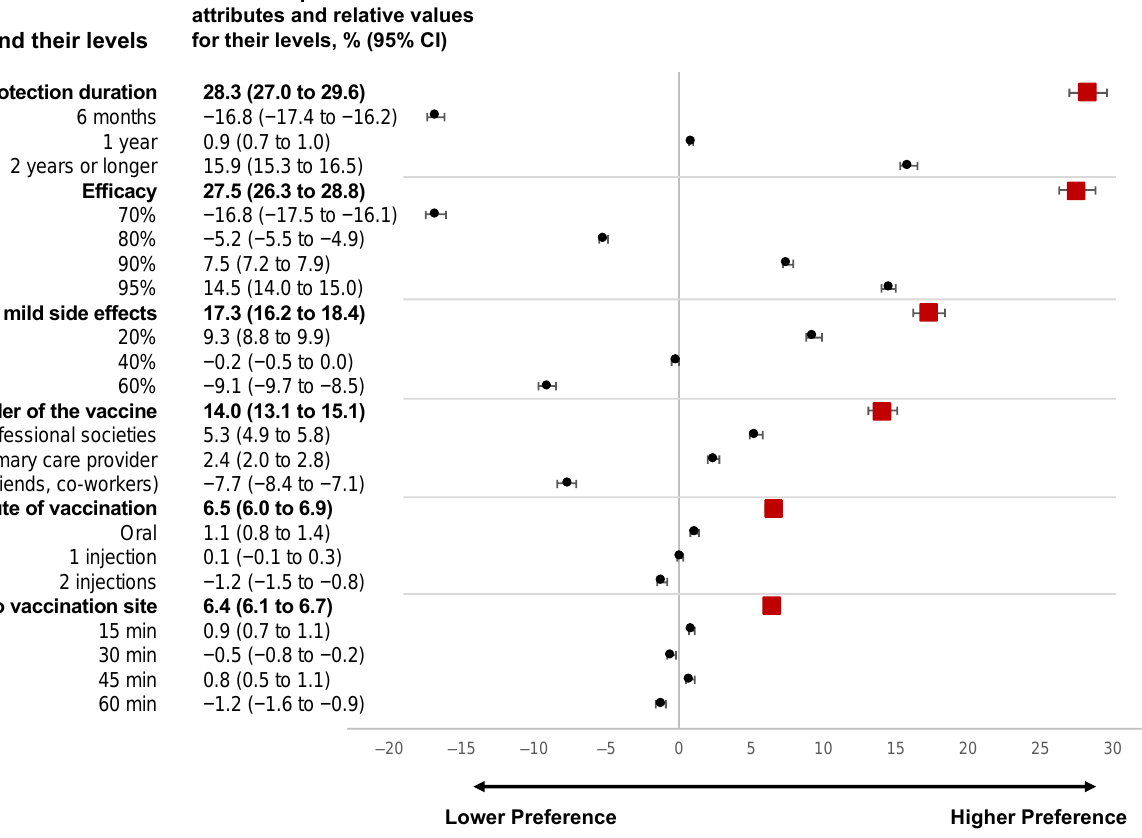
Figure 3. The relative importance of attributes and relative values of attribute levels. Attributes are ordered from the most important to the least important. Squares correspond to the relative importance of attributes and the lines represent 95% confidence interval. Circles correspond to the relative values of attribute levels and the lines represent 95% confidence interval.